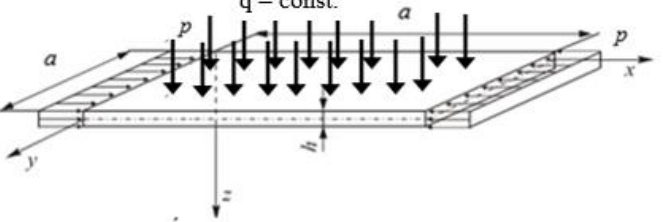
Figure 1. Square plate fixed along all edges and subject to simultaneous compression and uniform transverse load.